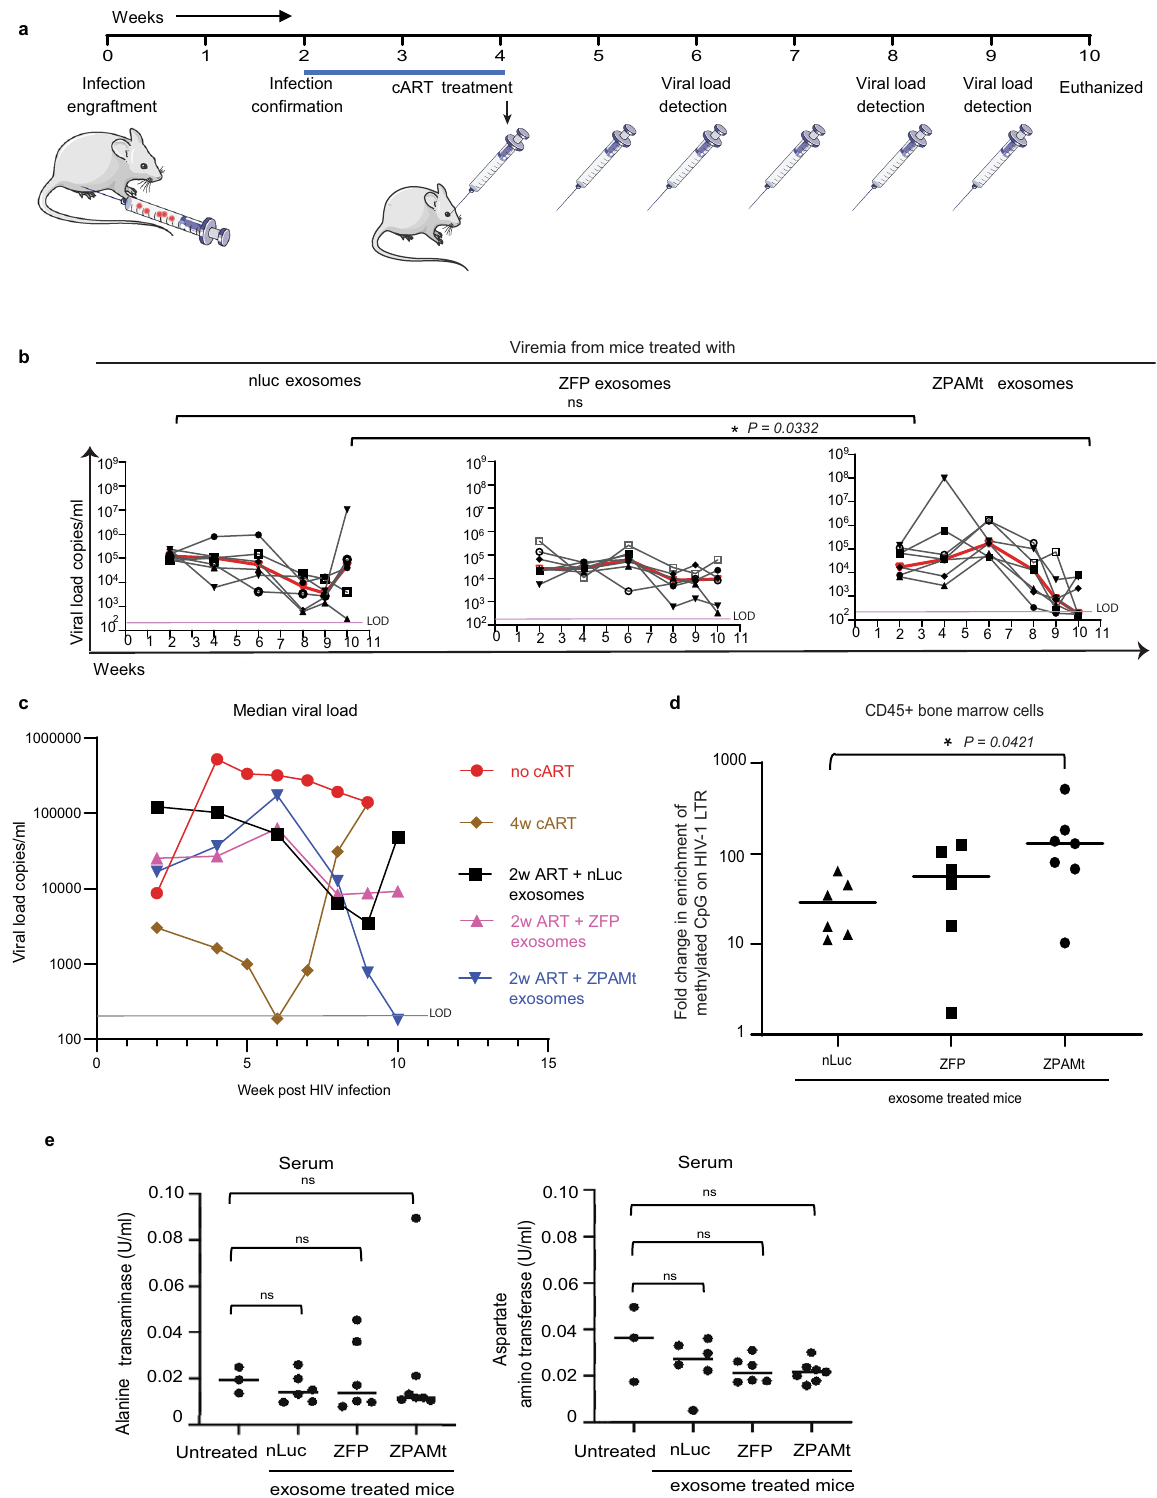
found to be signi fi cant in ZPAMt exosome-treated mice compared to controls in the bone marrow and spleen tissue lysates of CD34 + mice (Fig. 5d, e). To assert that signi fi cant repression in viremia levels were not due to the dwindling population of CD4 + cells, CD4 + cells were acquired from fi xed peripheral blood of mice before the start of treatment and after mice were euthanized. Following the gating strategy shown in Supplementary